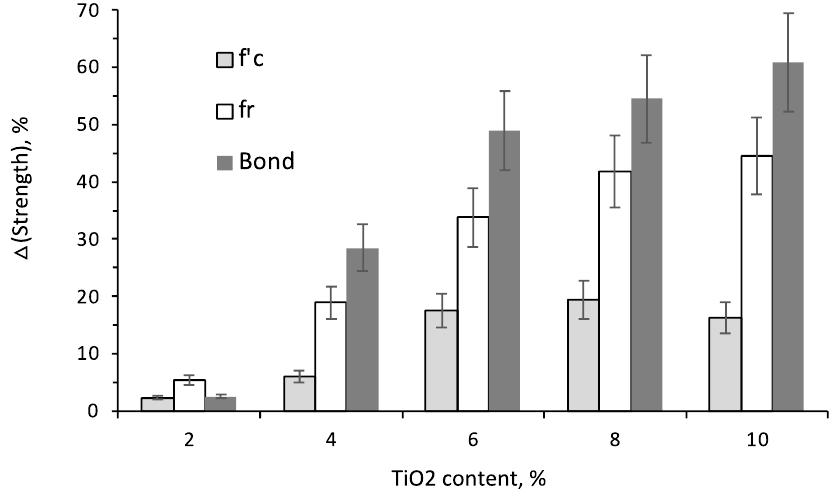
Figure 6. Effect of TiO 2 additions on Δ(f’c, fr, and Bond) values.